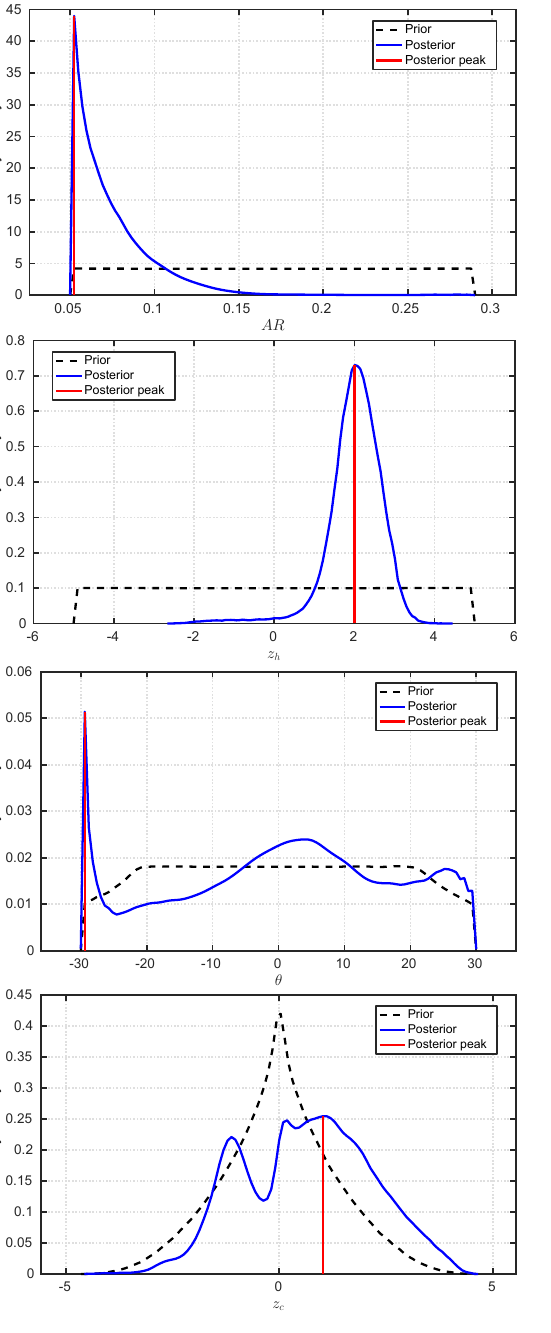
Figure 10. Prior (dashed black, derived from uniform ξ distribution in (cid:52) ) and posterior (solid blue) distributions of physical fault plane configuration parameters. The bottom right panel shows the inferred fault plane